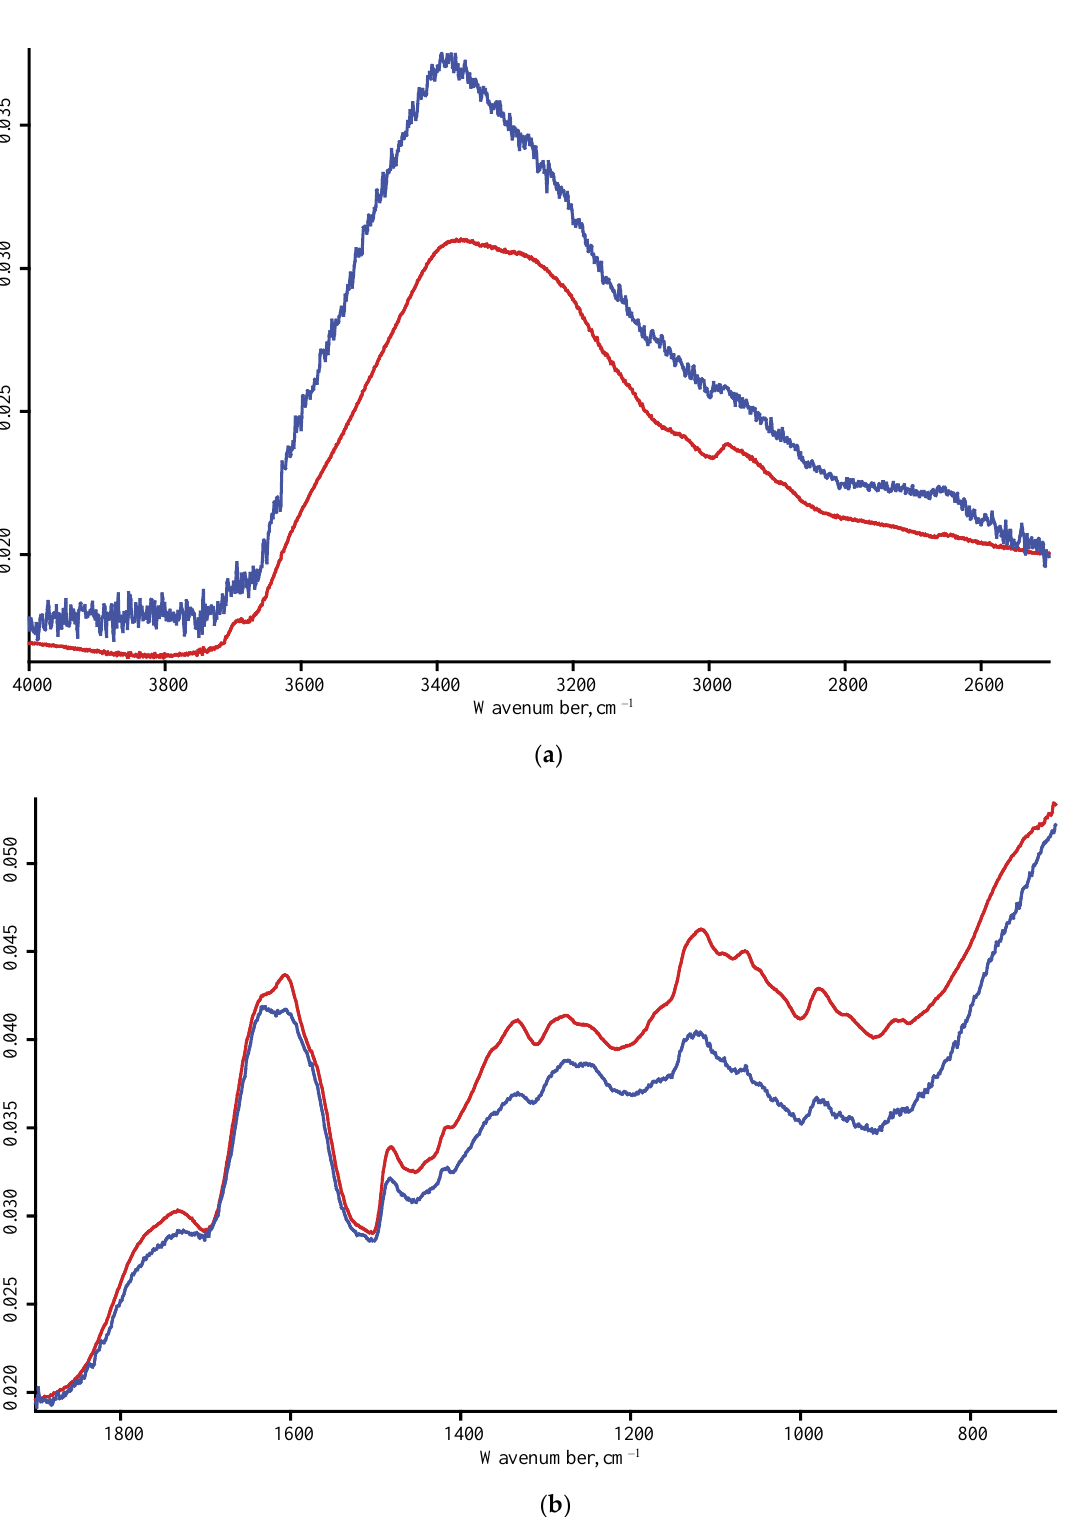
Figure 11. UDA-GO-SP-M1 nanodiamonds; red, ATR mode with a photovoltaic MCT detector; blue, diffuse reflectance mode with a photovoltaic MCT detector; green, photoacoustic mode. Spectra were not smoothed but normalized to maximize each spectrum.